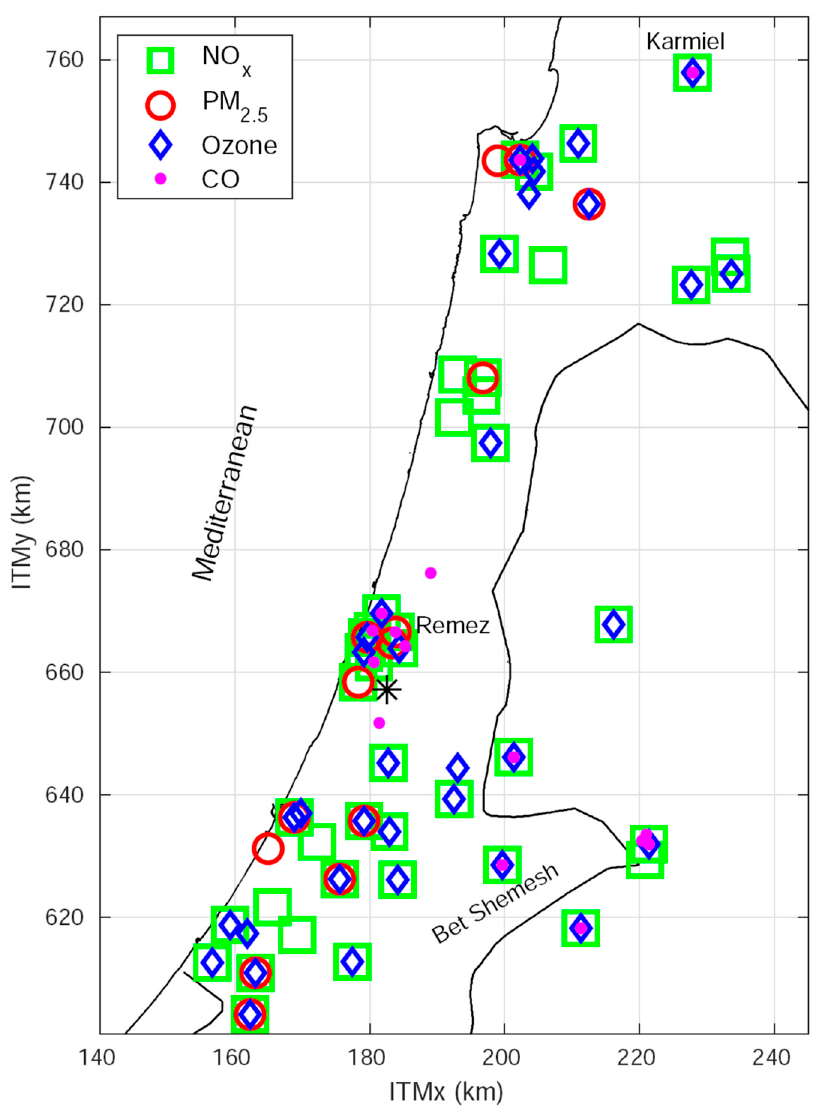
Figure 1. The study area and the spatial distribution of the air quality monitoring (AQM) stations from which the observations of NOx, PM 2.5 , O 3 and CO were gathered. The black asterisk denotes the location of the Bet Dagan meteorological station. The coordinates are in the Israeli Transverse Mercator (ITM) projection.